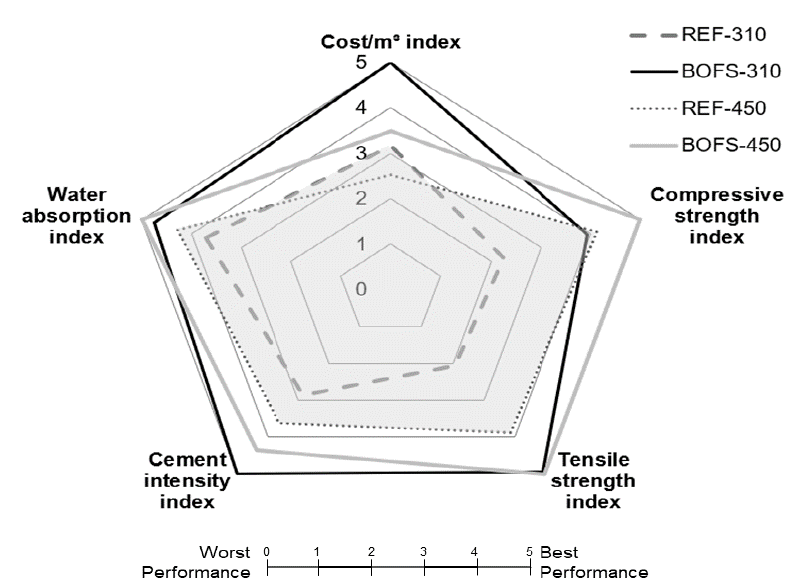
Figure 9. Radar chart of the technical, economic and environmental performance analysis of the concretes. Parameters are normalized, where 5 is the best performance and 0 the worst